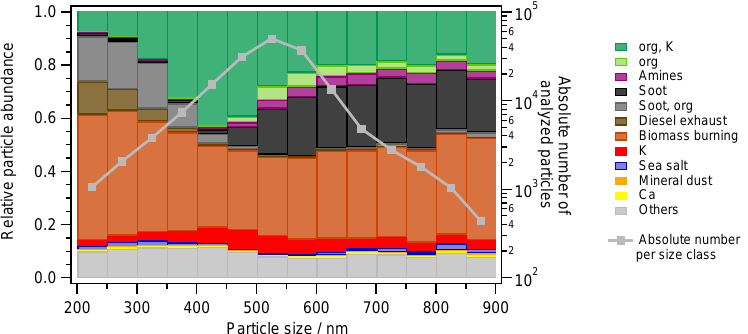
Figure 3. Size-resolved aerosol composition of the resulting particle types detected by the ALABAMA, binned into 50nm size intervals. The absolute number of analysed particles per size class is given by the grey line. Table 4. Absolute and relative particle numbers detected by ALABAMA during the HCCT-2010 campaign. The percentage of each particle type is subdivided into the fraction revealing a diurnal trend and into the fraction without diurnal trend. All percentages refer to the total number of 177752 analysed